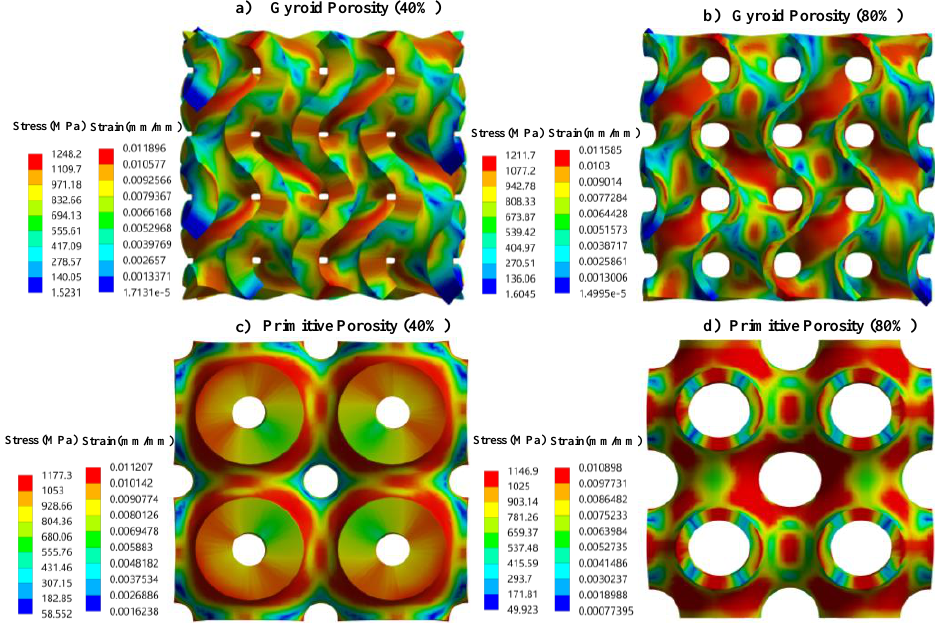
Figure 8. Resulting Von Mises stress and strain distributions of ( a , b ) G and ( c , d ) P, at end compression value of 5%.